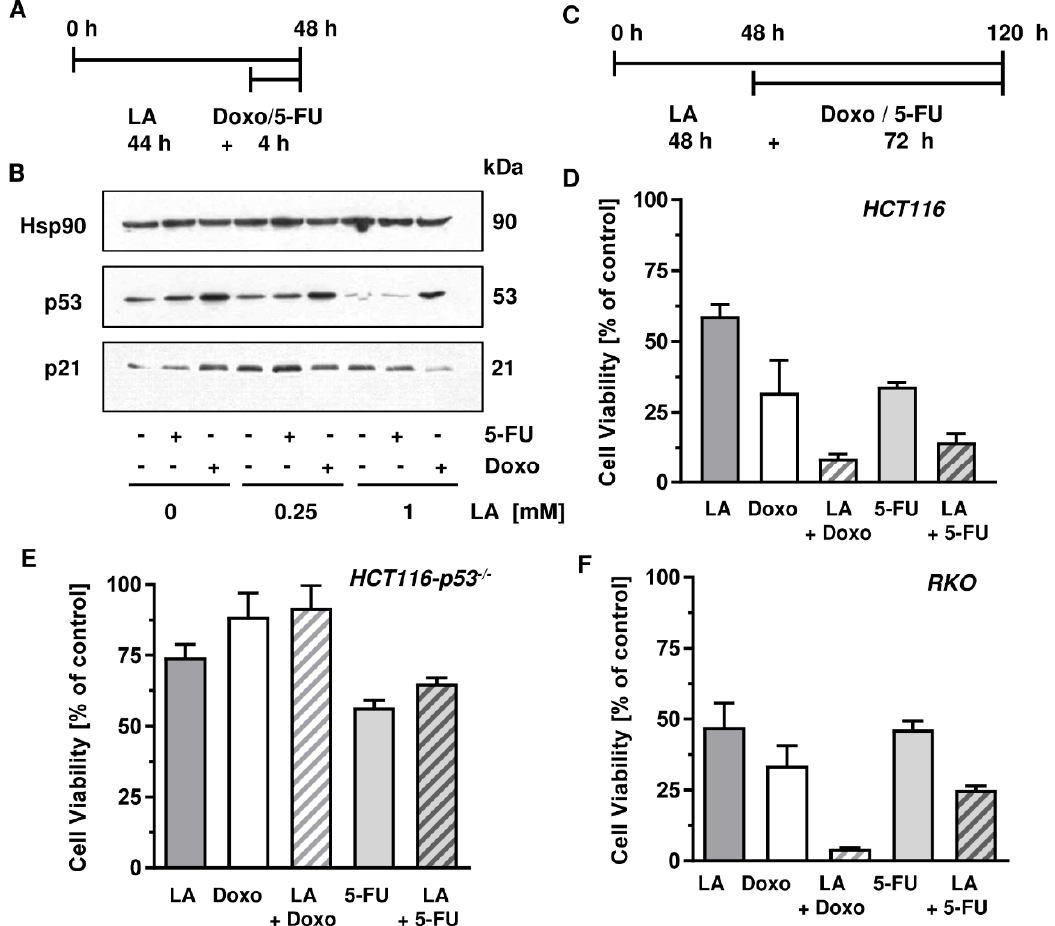
Figure 8. LA attenuates p53 stabilization upon genotoxic stress and synergizes with Doxo and 5-FU. ( A , B ) Combination of LA with Doxo or 5-FU, respectively, in HCT116 cells and effects on p53 and its downstream target p21. Cells were treated as indicated in A and harvested after 48 h. Samples were then analyzed with respect to p53 and p21 by SDS-PAGE and western blot. Hsp90 served as loading control. ( C ) Treatment scheme of ATP assays in HCT116, HCT116-p53 − / − , and RKO cells to determine the combination index. Cells were pre-treated with LA for 48 h and then supplemented with either ATP assays according to the treatment scheme depicted in ( C ) in HCT116 (( D ); 1 mM LA, 10 µ M 5-FU,